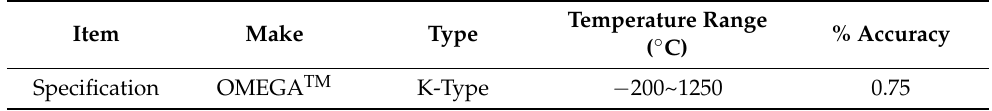
Table 5. Technical details of